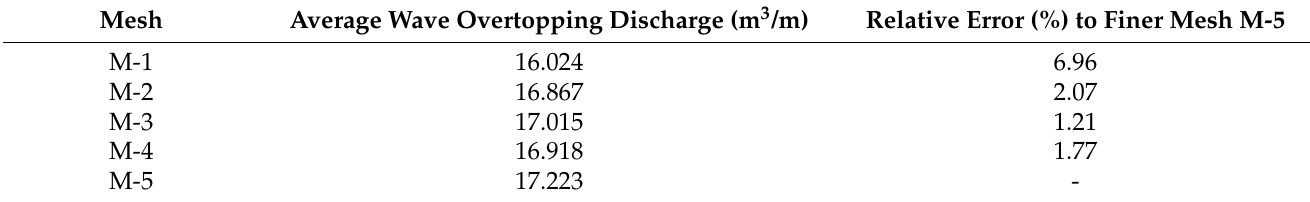
Figure 6. Time series of the wave overtopping discharge for meshes M-1 to M-5. Table 2. Average wave overtopping discharge for meshes M-1 to M-5.